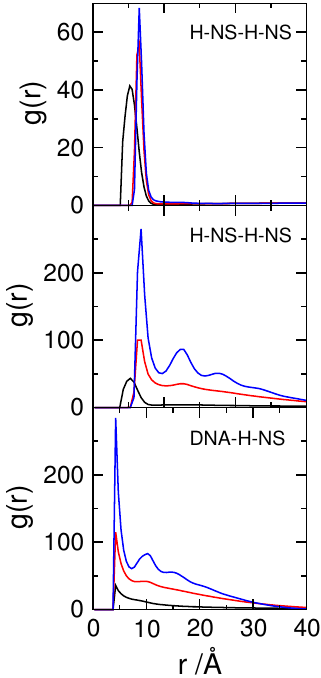
Figure 4. Radial distribution functions, rdf, of H-NS–H-NS segments and DNA–H-NS segments (as indicated), for systems with 60 H-NS dimers in the absence (top panel) and presence (middle and bottom panels) of DNA. The H-NS–H-NS attractive potential, ε pp , is 0 (black), 1 (red) and 2 (blue) kT. Φ crow = 0.